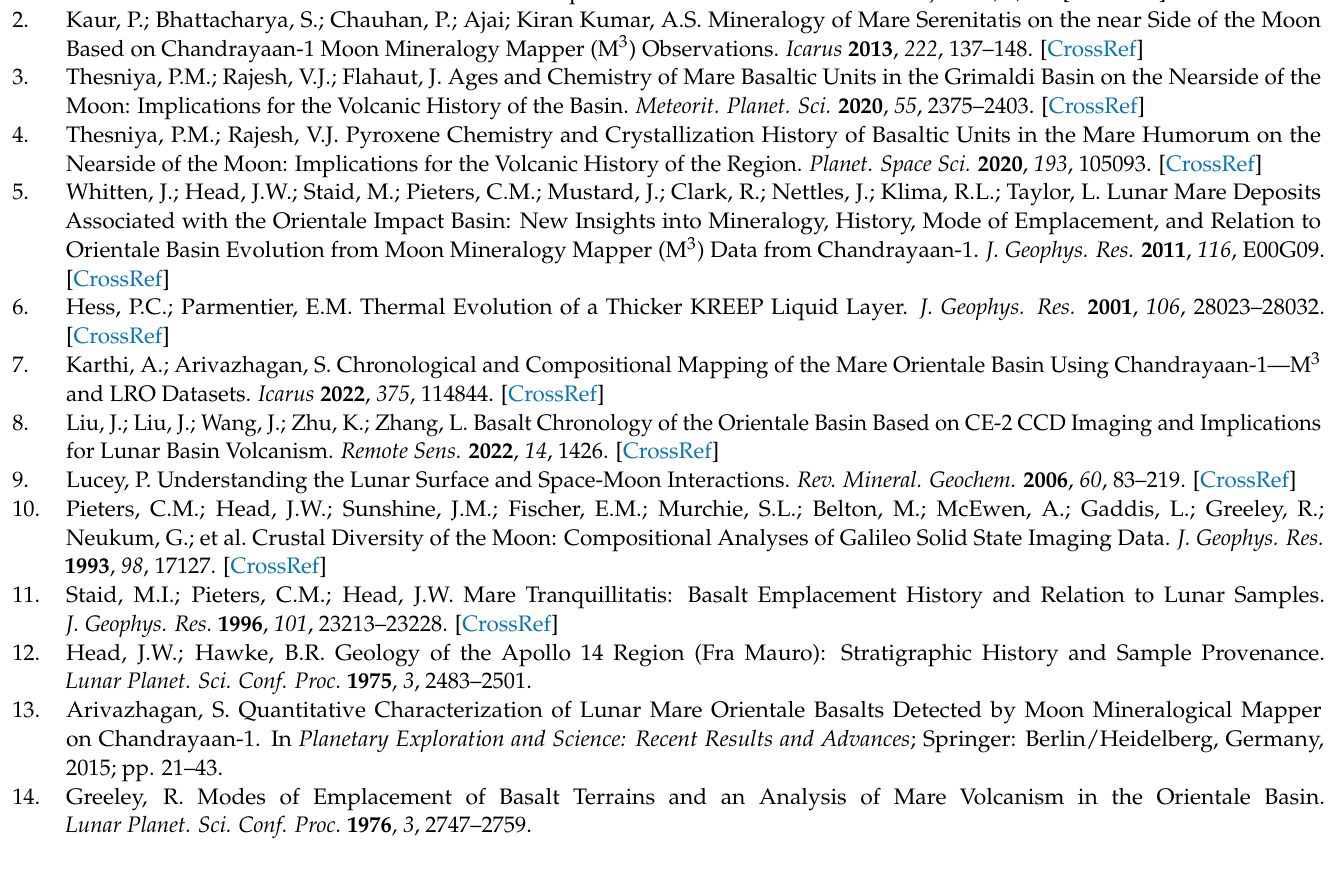
in Figure 4d. Figure S3: Reflectance spectra of different minerals from the Kopff Crater and the Lacus Autumni region are shown in (a–h). Normal reflectance spectra and continuum-removed reflectance spectra for K, LA1, LA2, and LA3 basaltic units have been plotted. The locations where spectra were collected are identified and marked in Figure